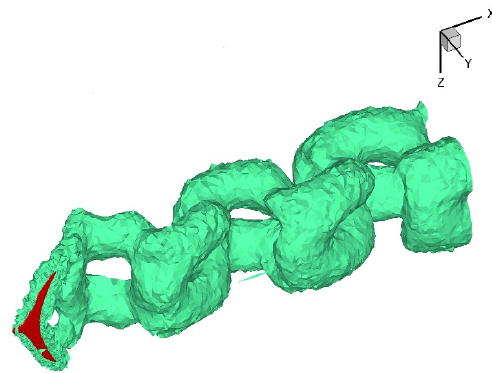
Figure 8. Vortex pattern behind the fin.